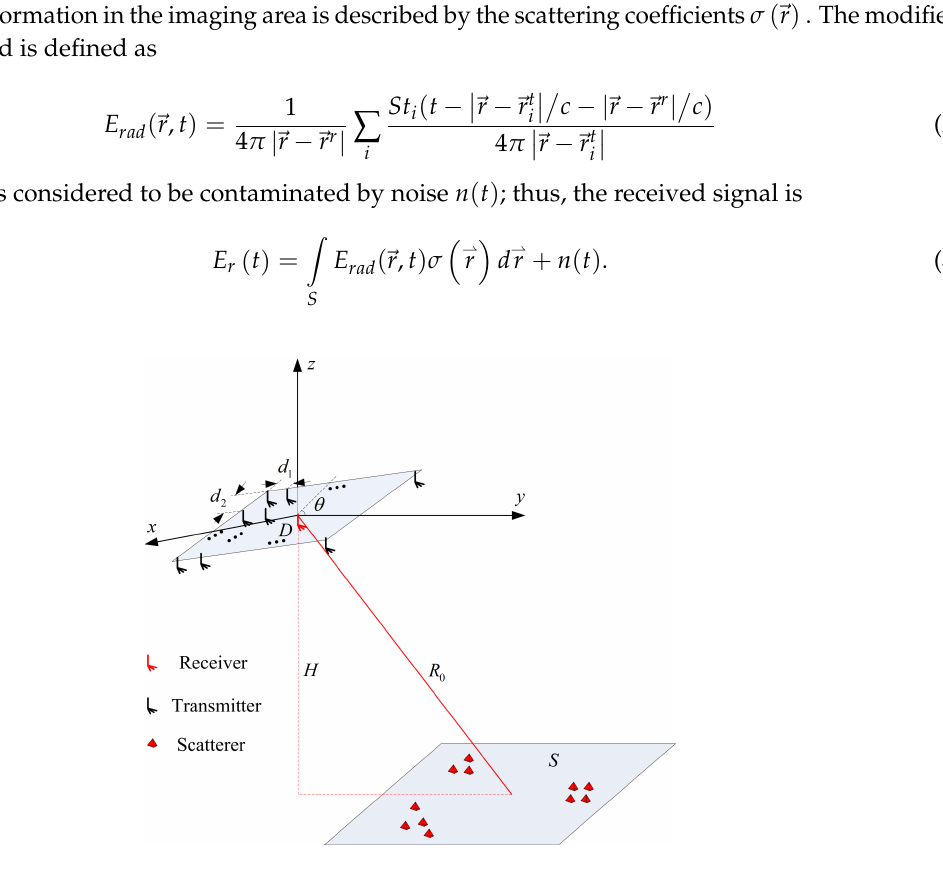
Figure 1. Imaging geometry of the microwave staring correlated imaging